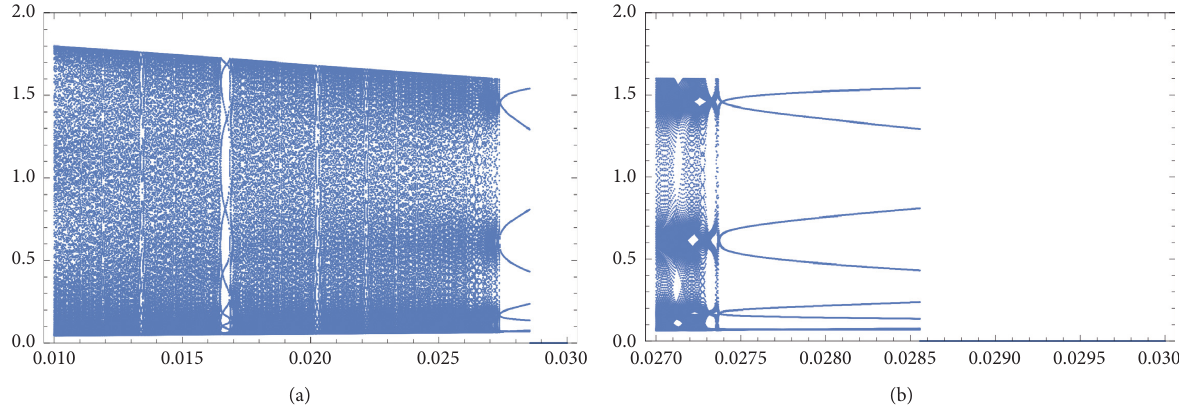
Figure 6: (a) Bifurcation diagram of equation (1) for a � 0 . 52 indicating occurrence of chaos and the convergence to the period 7 solution. (b) Bifurcation diagram of equation (1) for a � 0 . 52 indicating the global attractivity of period 7 solution and period 8 solutions following the chaos. Table 1: The table with numerical comparison of rates of con- vergence when a � 0 . 53 ,f � 0 . 140, and x + � 0 . 450463. Iterations to x 0 x � 0.2 x 0